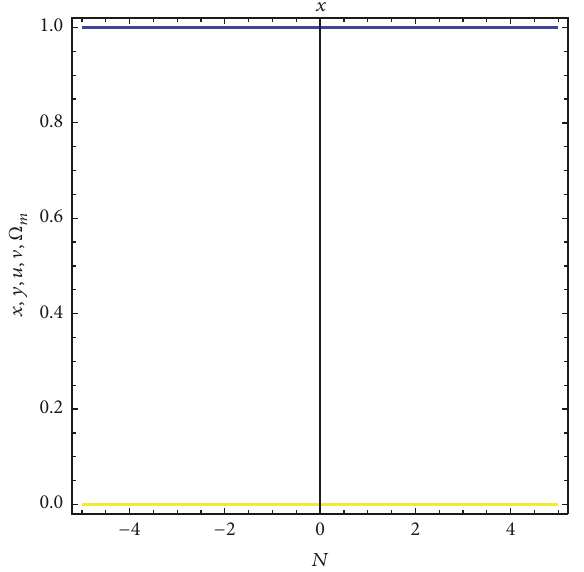
Figure 1: Plot of ( 1 ) variations of 𝑥 (blue), 𝑦 (green), 𝑢 (orange), V (red), and Ω 푚 (yellow) versus 𝑁 near 𝑃 1 , for 𝛾 = 1 , 𝛿 = 0.5 , and 𝜆 = −0.5 . The position corresponding to 𝑁 = 0 is the fixed point under consideration.